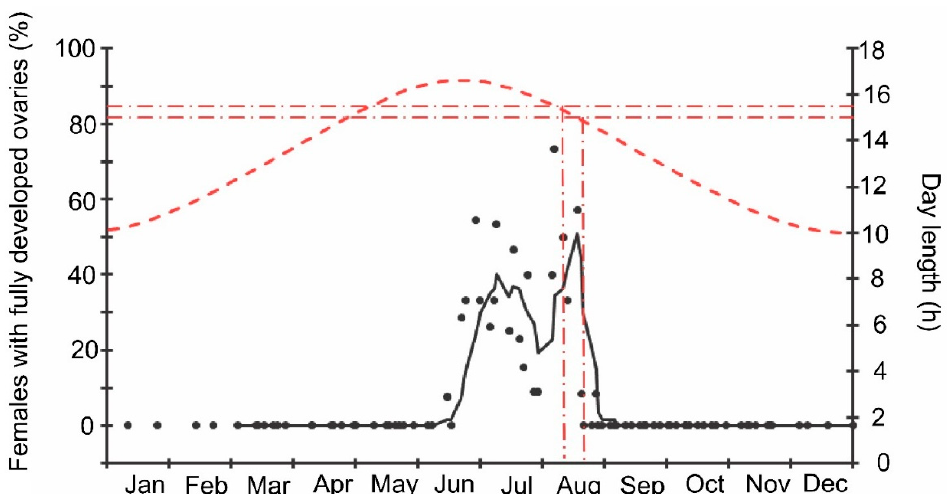
Figure 9. Seasonal changes in the proportions of Halyomorpha halys females with fully developed ovaries during 2018–2021 in relation to natural day length. Upper graph, right vertical axis, dashed red line—natural day length including civil twilight [45]. Lower graph, left vertical axis, black symbols—the proportions of H. halys females with fully developed ovaries (data of four seasons are pooled, each symbol corresponds to one sample of field-collected females (6–35 females per sample with a total of 1180 females in 85 samples)), black trend line is a moving average of five points (produced in Excel 2016). Red dash-dotted lines show the threshold zone of H. halys photoperiodic response of winter adult diapause induction estimated from the earlier laboratory experiments (15.0–15.5 h [16]) and its projection to the calendar axis.